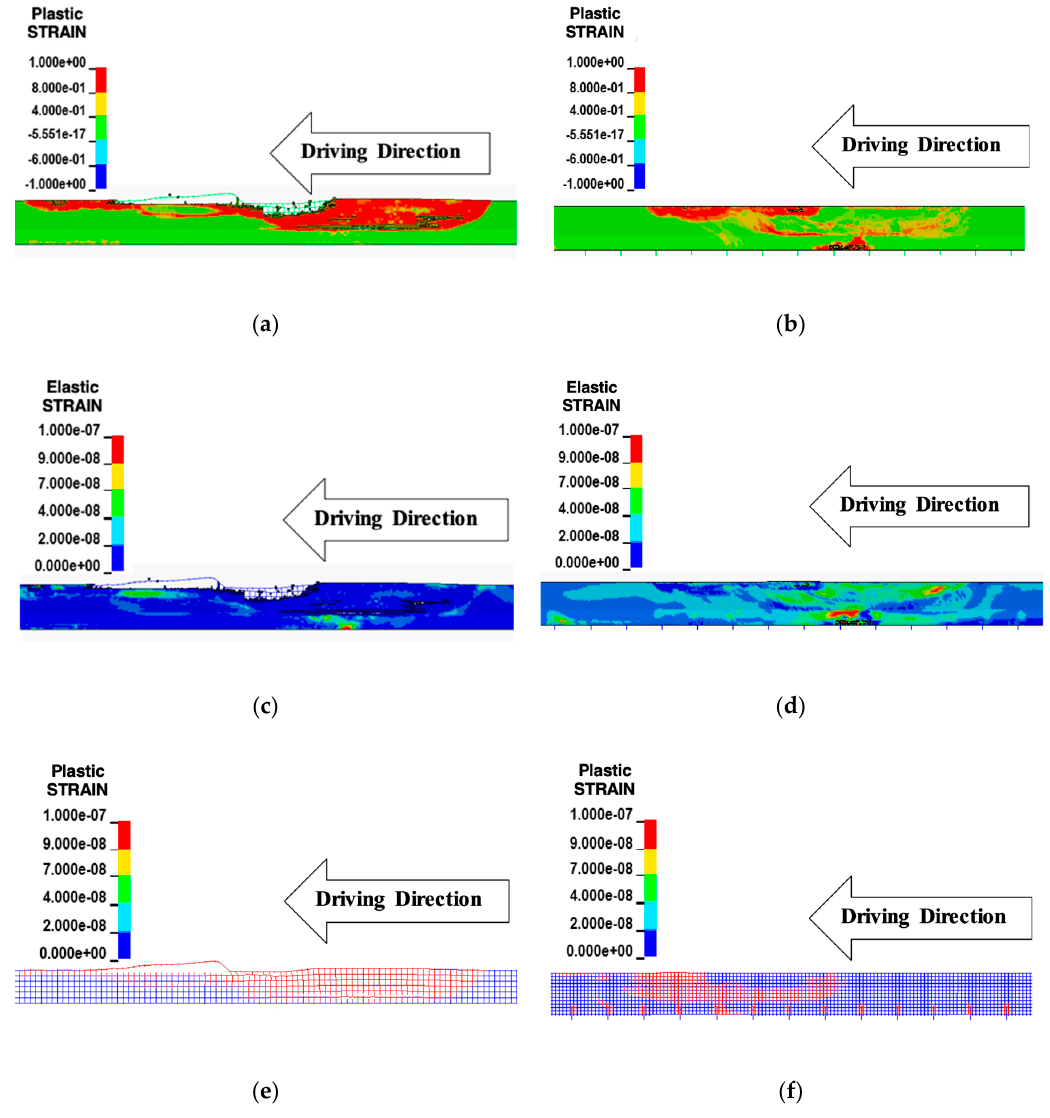
Figure 9. Damaged zones of CMB-15 and CMB-17S. ( a ) Plastic strain of concrete (CMB-15); ( b ) plastic strain of concrete (CMB-17S); ( c ) elastic strain of concrete (CMB-15); ( d ) elastic strain of concrete (CMB-17S); ( e ) plastic strain of wire-mesh (CMB-15); ( f ) plastic strain of wire-mesh (CMB-17S) .